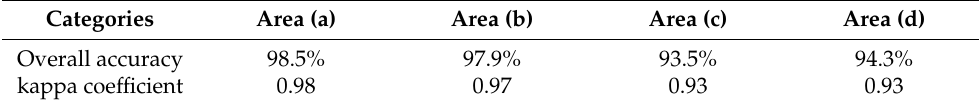
Table 4. Overall accuracy and Kappa coefficient.